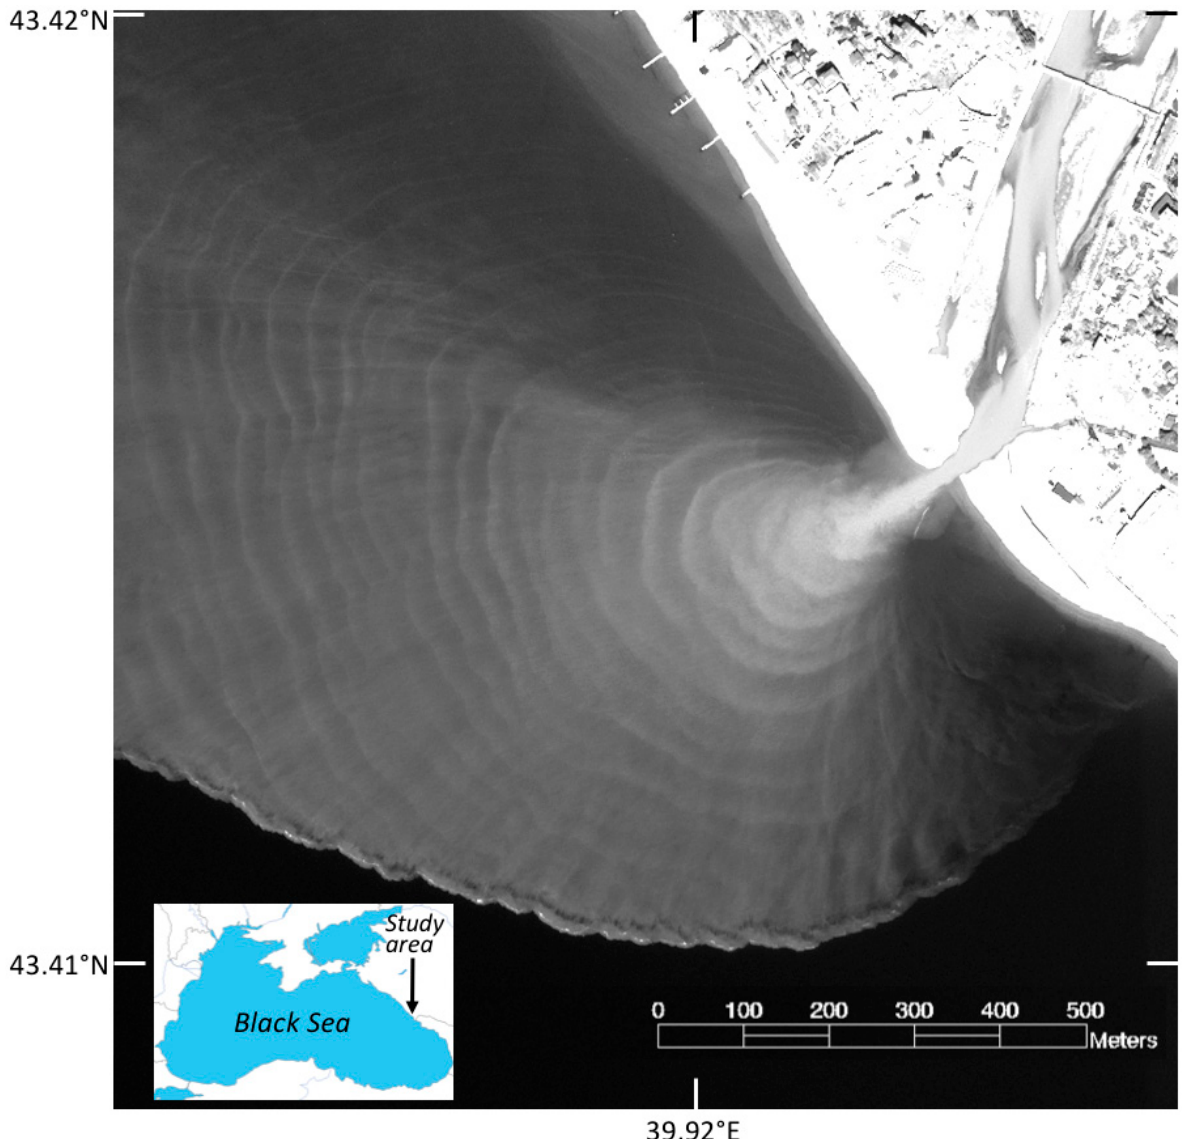
Figure 1. WorldView-3 image of the Mzymta River plume on 4 April 2017, illustrating the nearly concentric bands, or “rings”, that are the focus of this study. Shown are band 3 data (518 to 586 nm wavelengths), geo-referenced to a UTM map projection (zone 37N; WGS-84), and using square 1.4-m pixels. An independent color-composite version appears in reference [4]. WorldView-3 is a commercial Earth observation satellite owned by DigitalGlobe, Inc., Westminster, CO,